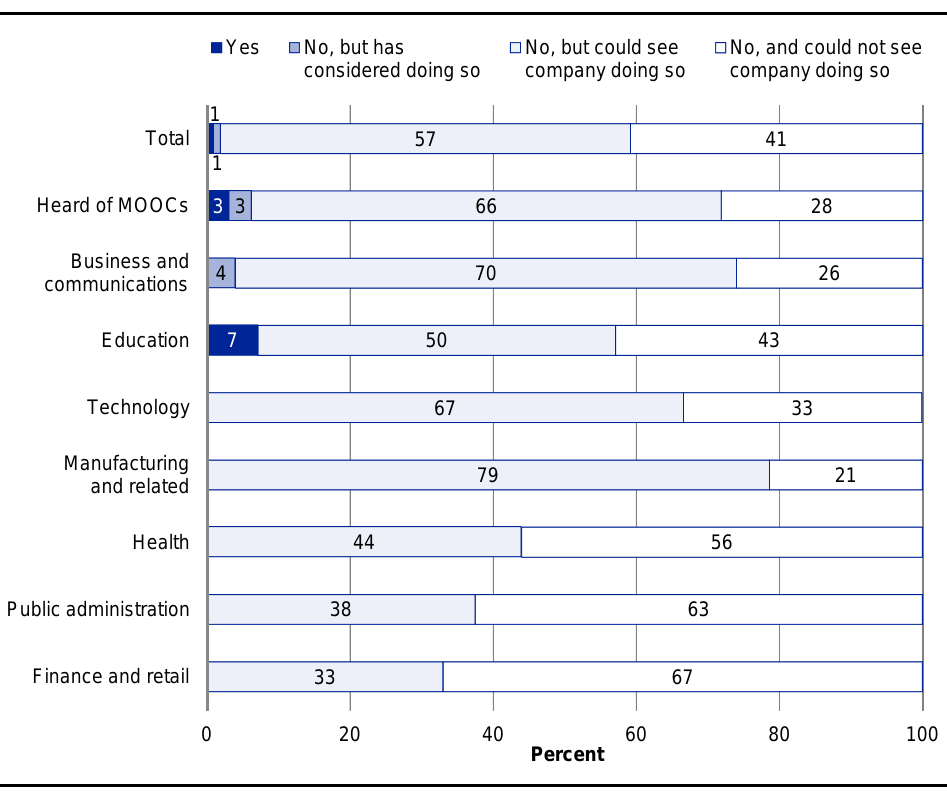
Figure 4. Percentage distribution of organizations that had used, considered using, or were open to using MOOCs for recruitment: among all respondents, those that had heard of MOOCs prior to the survey, and by